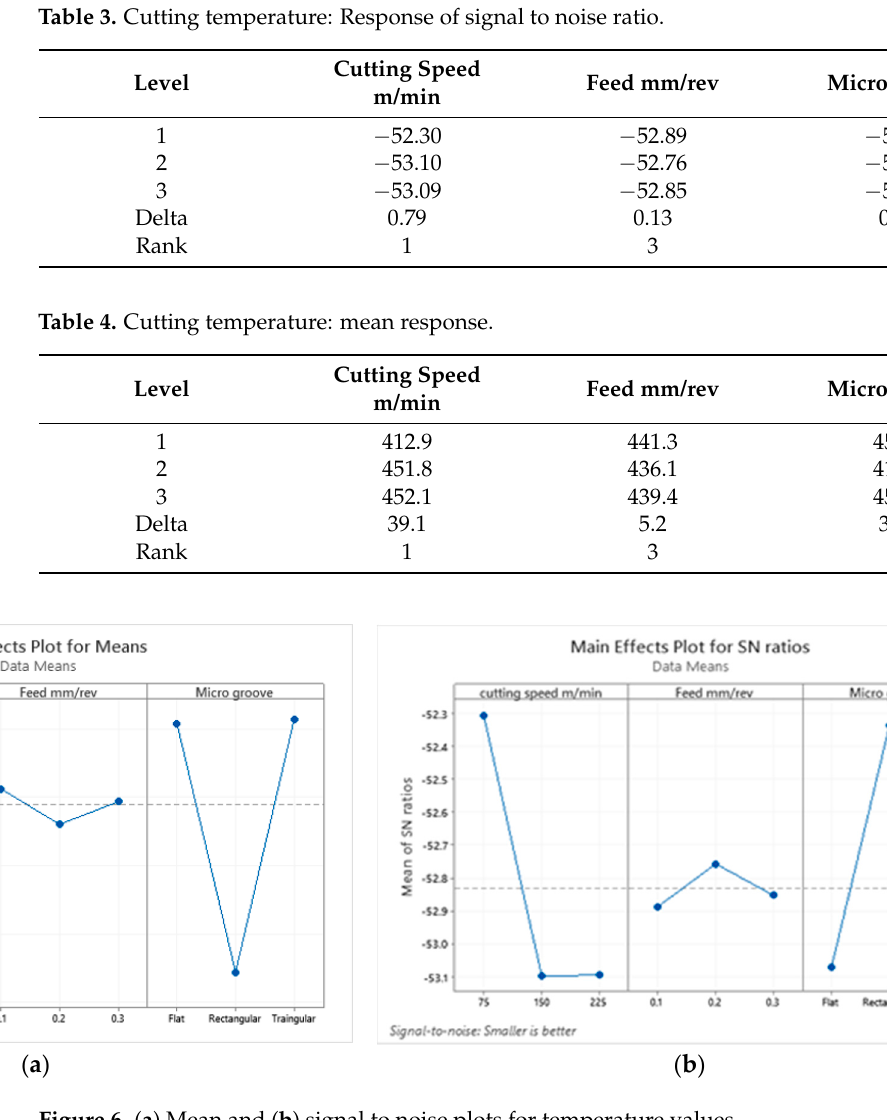
Table 3. Cutting temperature: Response of signal to noise ratio.